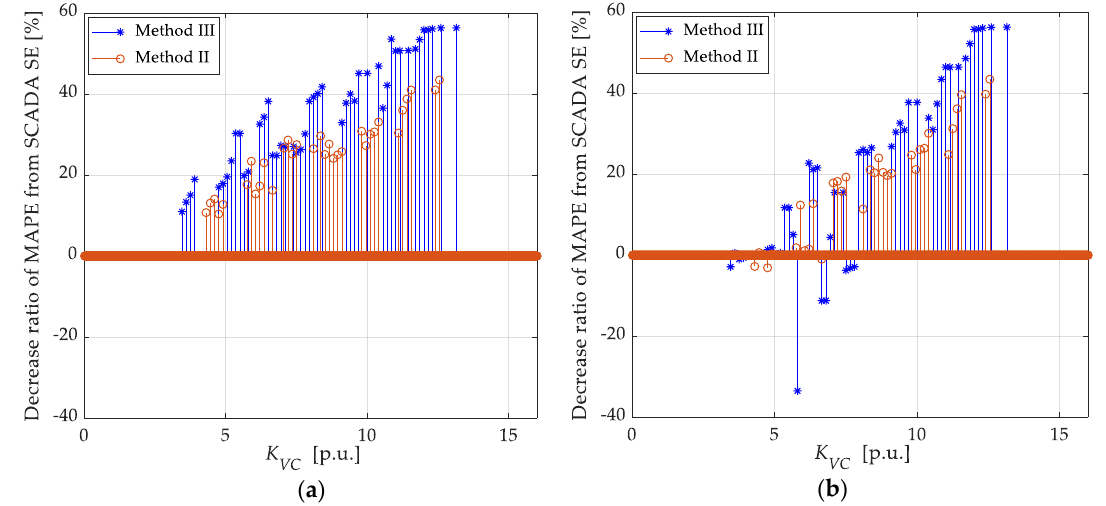
Figure 10. Decrease ratio of the Mean Absolute Percentage Error (MAPE) from SCADA SE for all Pareto solutions in Methods II and III. ( a ) Discarding estimated state by PMU, ( b ) Without discarding estimated state by PMU.